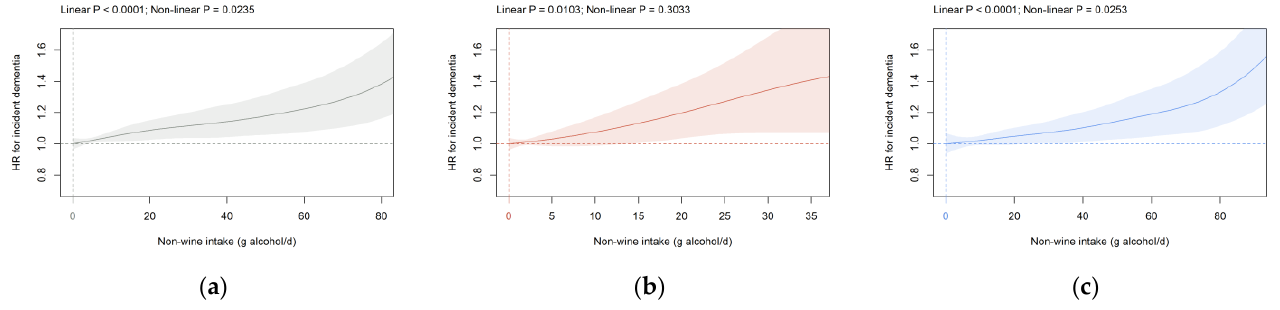
Figure 2. Association of non-wine intake (g alcohol/d) with dementia risk in the primary cohort in ( a ) all participants, ( b ) females, and ( c ) males. Data are adjusted and presented as indicated in Figure 1.